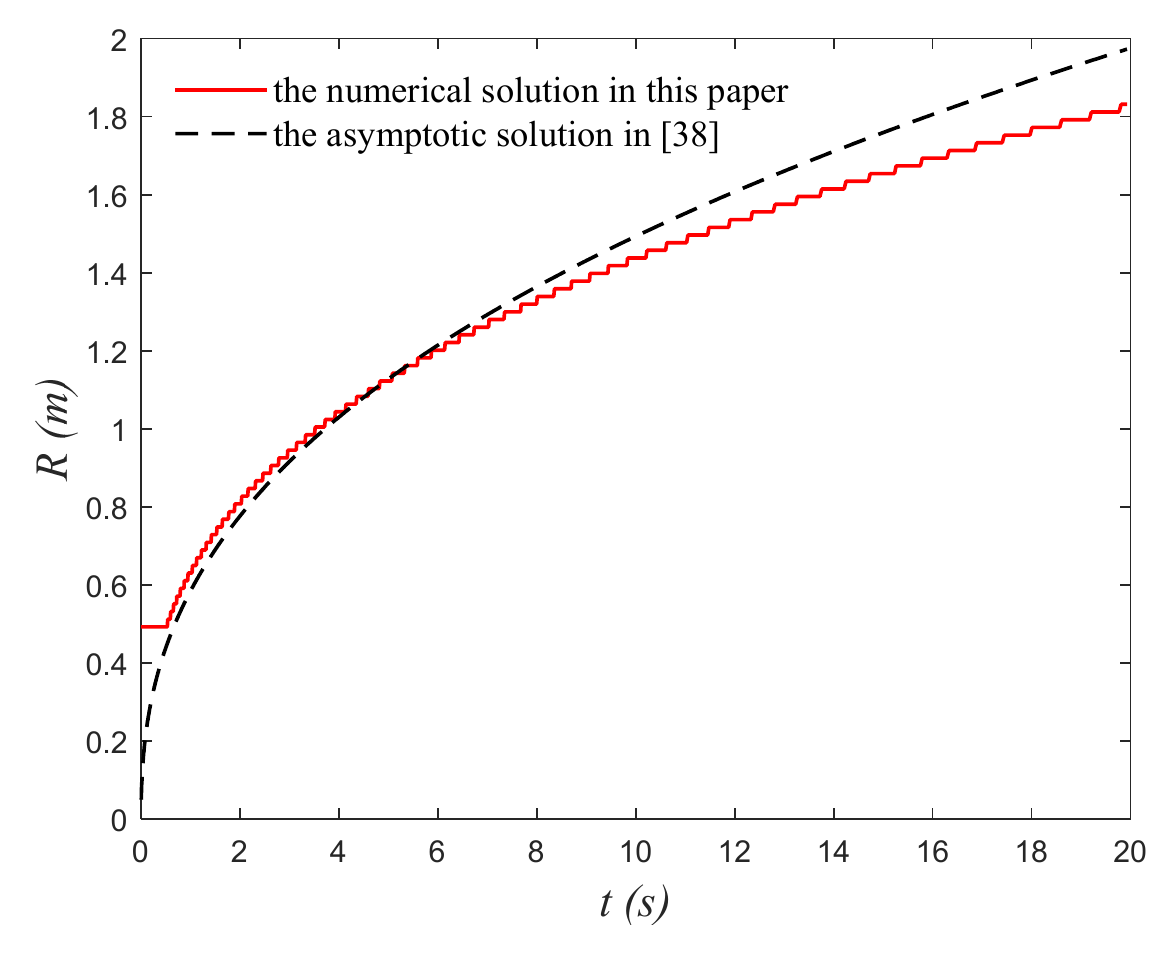
Figure 14. Comparison of the fracture radius of the large-toughness asymptotic solution and the numerical solution under the uniform propagation in this paper.